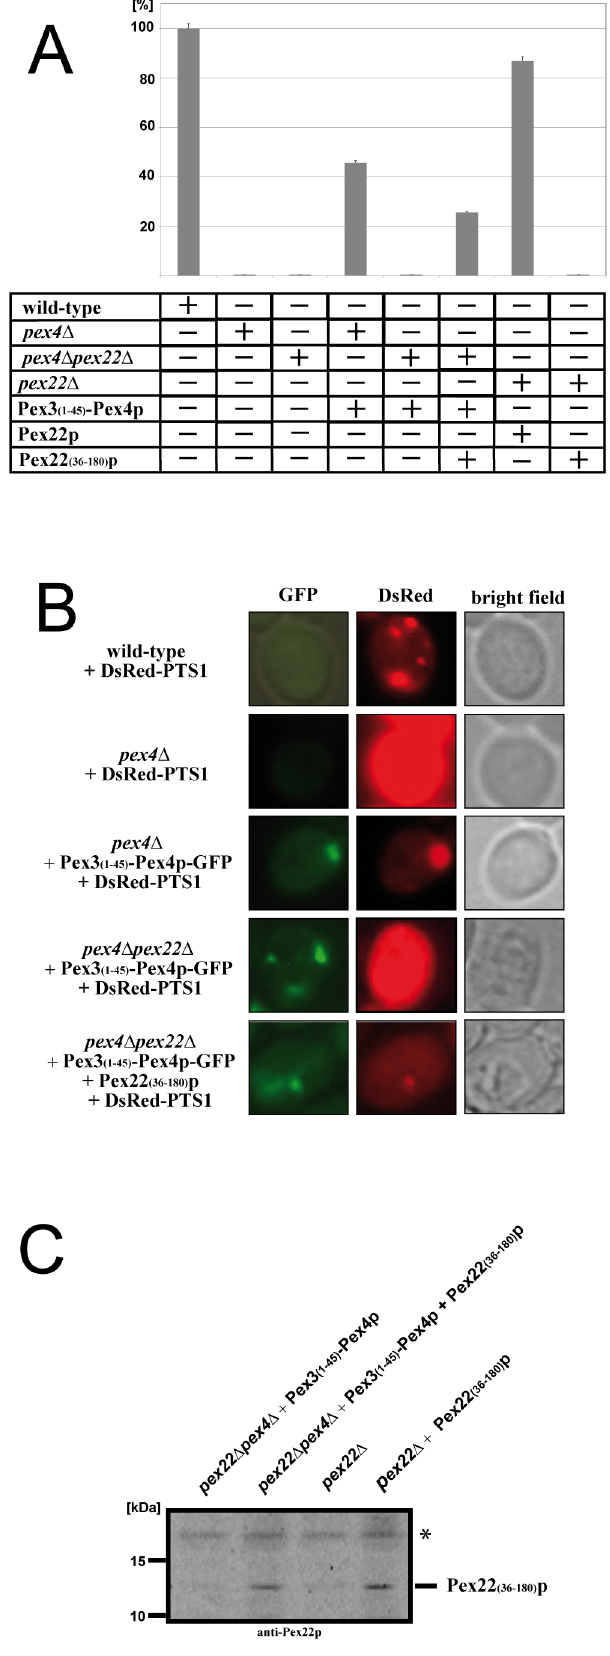
Figure 2. The function of Pex22(C)p is essential for peroxisome biogenesis, while Pex22(N)p is dispensable. ( a ) Peroxisomal function was tested by analyzing the capability of the plasmid-encoded constructs to complement the mutant growth phenotype of corre- sponding deletion strains. To this end, the Pex3(N)-Pex4p, Pex22(C)p and/or Pex22p were expressed in the pex4 D pex22 D , pex4 D or pex22 D deletion strains, as indicated. The optical density at 600 nm (OD600) of cells grown in oleate medium was monitored (n=3 experiments) and results are presented in relation to growth of the wild-type, which is set as 100% ( + / 2 standard error of the mean). The corresponding OD600 at the end of the growth period is depicted. While Pex3(N)-Pex4p can complement the growth defect of the pex4 D strain, it is only capable to regain functionality in the pex4 D pex22 D background, when Pex22(C)p is present. ( b ) Peroxisomal function was tested by analyzing the capability of the plasmid-encoded constructs to complement the peroxisomal protein import defect of corresponding deletion strains. Plasmid- encoded DsRed-PTS1 served as marker for peroxisomal protein import. Transformed cells were grown on oleic acid plates for two days and examined by fluorescence microscopy. The wild-type cells as well as the pex4 D strain carrying the Pex3(N)-Pex4p plasmid displayed a punctate pattern, indicating that DsRed-PTS1 cargo is imported into peroxisomes and which is the typical appearance of cells with intact PTS1-dependent matrix protein import. The non-transformed pex4 D strain as well as the pex4 D pex22 D strain with Pex3(N)-Pex4p displayed a cytosolic staining of the DsRed-signal, demonstrating that the marker is mislocalized to the cytosol due to a block of import. The pex4 D pex22 D strain expressing both Pex3(N)-Pex4p and Pex22(C)p displayed a heterogenous pheno- type of a partial cytosolic mislocalization but also detectable import of DsRed-PTS1 into peroxisomes. ( c ) The lysates of oleate-induced cells were analyzed for the level of Pex22(C)p. The detected level of Pex22(C)p was the same in both the strain with partial functional complementation ( pex4 D pex22 D + Pex3(N)-Pex4p + Pex22(C)p) and the strain without functional complementation ( pex22 D + Pex22(C)p). The asterisk denotes a cross-reaction